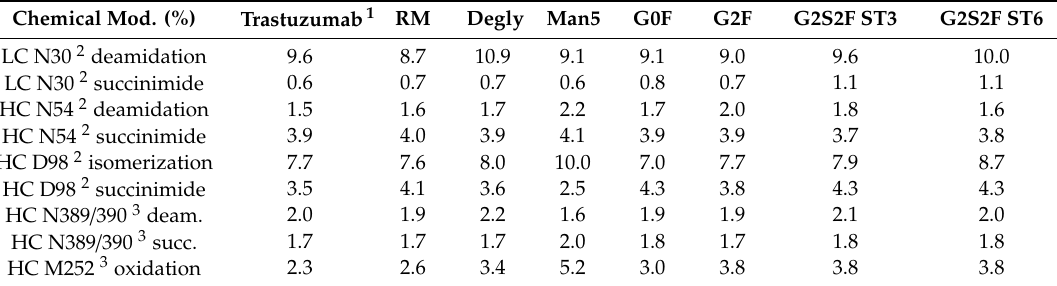
Table 2. Relative quantification of chemical amino acid modifications (LC-MS peptide mapping). Chemical Mod. (%) Trastuzumab 1 RM